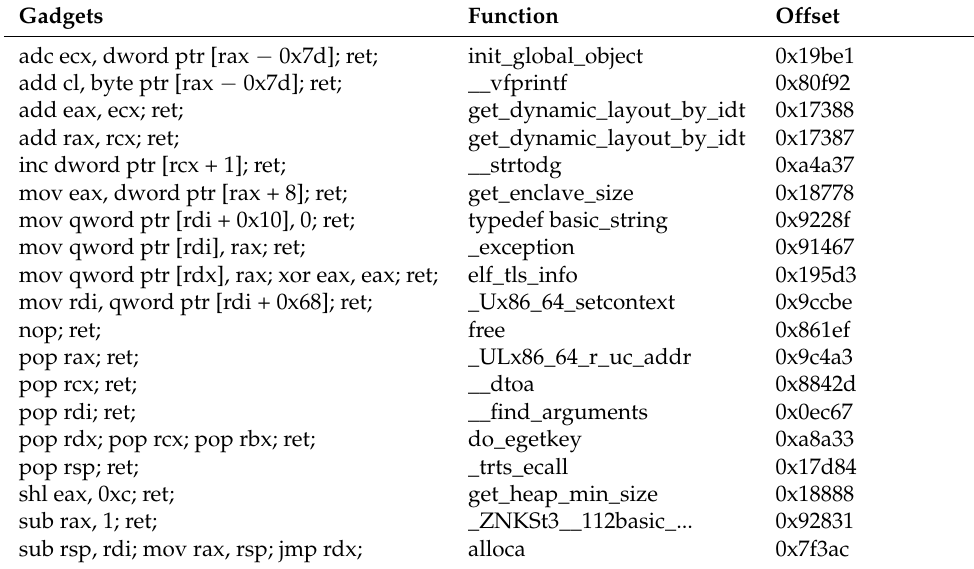
Table 1. Gadget list used in